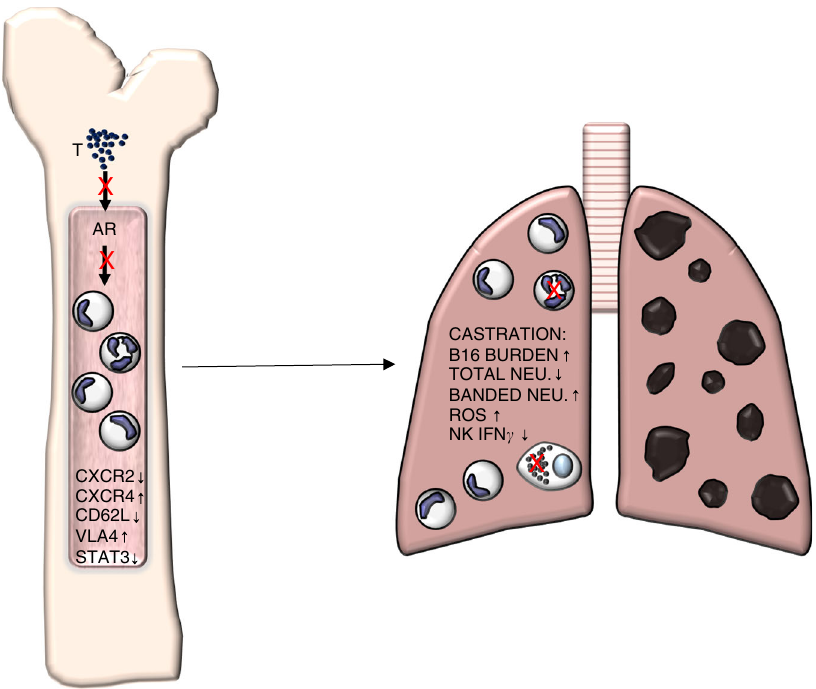
Fig. 6 Impact of testosterone on neutrophil phenotype using a representative B16-tumor model. In castrated male mice, testosterone is diminished and can no longer activate the androgen receptor (AR). This causes a decrease in CXCR2, CD62L, and STAT3 expression, and an increase in CXCR4 and VLA4 expression. These changes lead to more banded, immature neutrophils and an overall reduced number of neutrophils in circulation. Once B16 cells are injected via tail vein and allowed to metastasize to the lung, castrated male mice have a poor recruitment of mature, segmented neutrophils which leads to an increase of ROS-producing neutrophils, fewer NK + IFN γ -producing cells, and results in increased tumor burden and decreased survival compared with sham-operated male